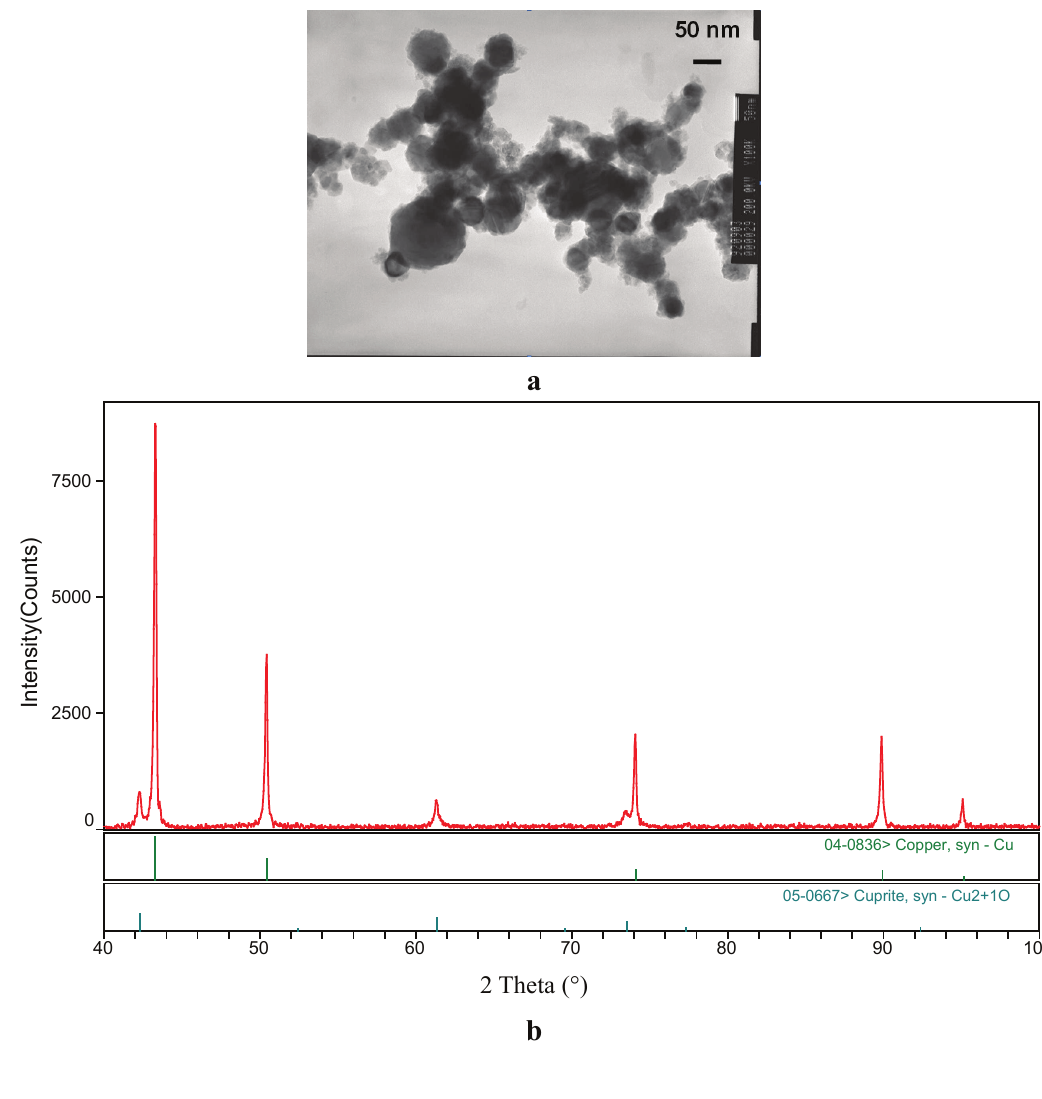
Figure 4. ( a ) Transmission electron micrograph of copper nanopowders produced by large-scale pilot production; ( b ) X-ray diffraction pattern of copper nanopowders produced by large-scale pilot